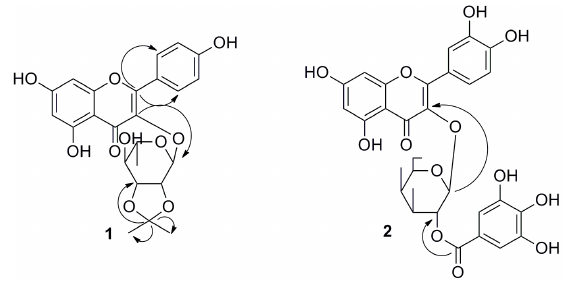
Figure 2. The key HMBC correlations of compounds 1 , 2 . Table 1. NMR data of compounds 1 , 2 ( 1 H: 600 MHz, 13 C: 150 MHz), δ in ppm a .